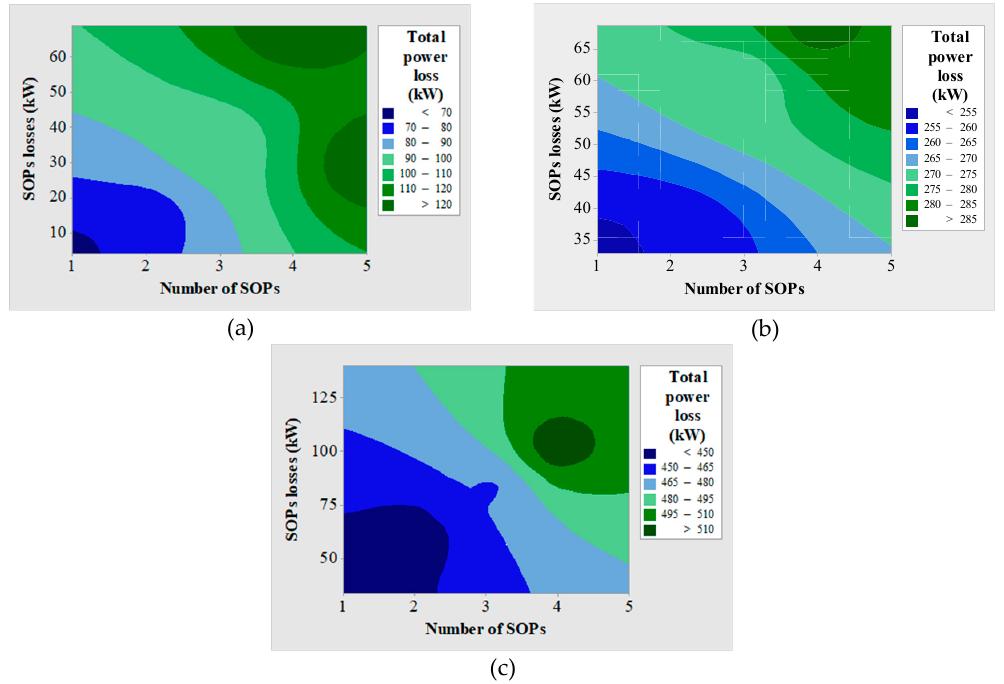
Figure 9. Contour plots of total power loss versus SOPs losses and N SOP : ( a ) light loading, ( b ) normal loading, and ( c ) heavy loading.